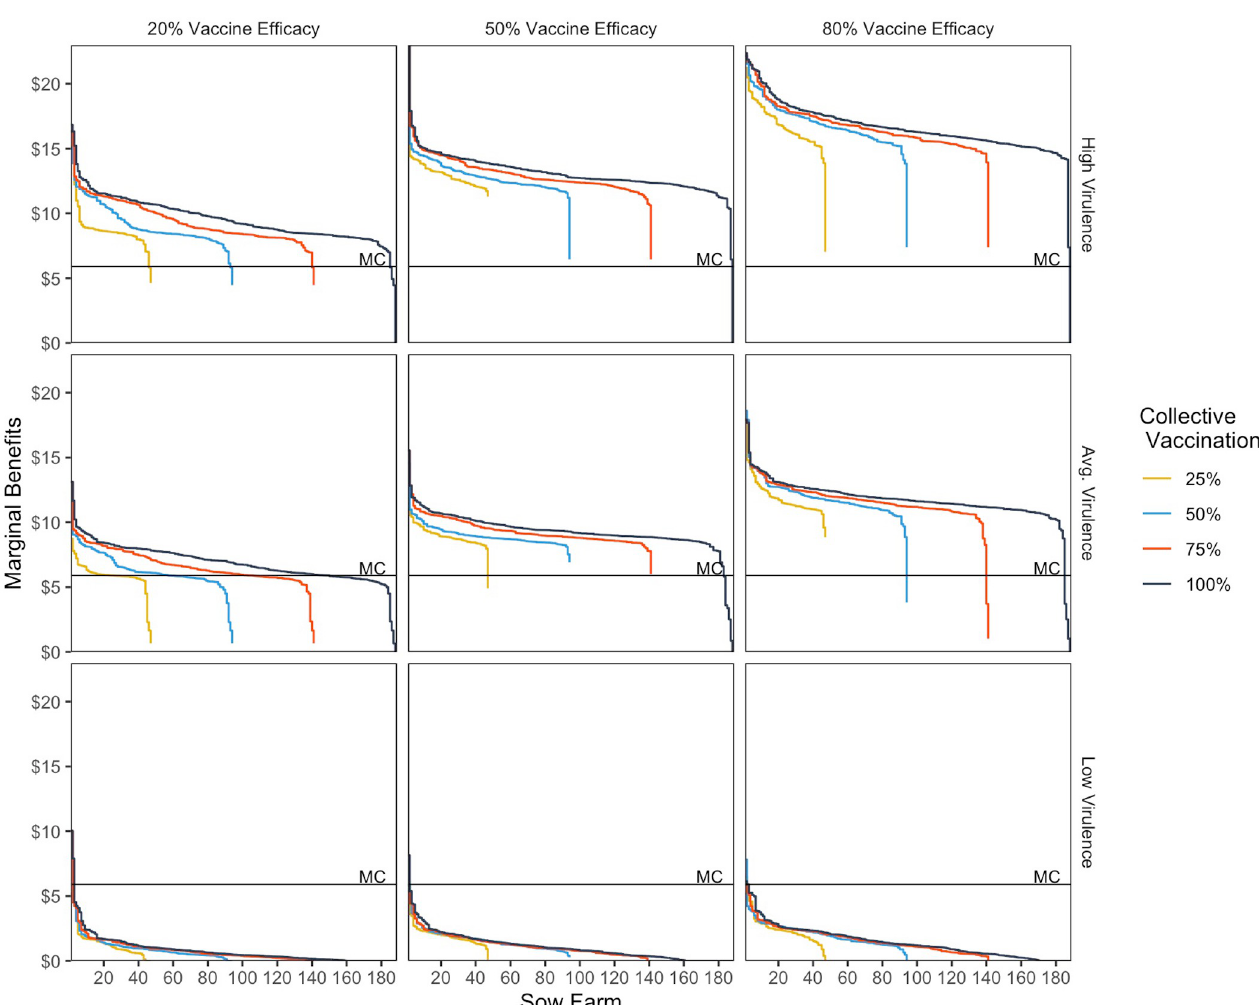
Fig 6. Marginal benefits of vaccination for three infecting strains, increasing amounts of collective vaccination and varying vaccine efficacy. Note: The estimated marginal cost of vaccination (MC) is a constant $5.90/year per animal.